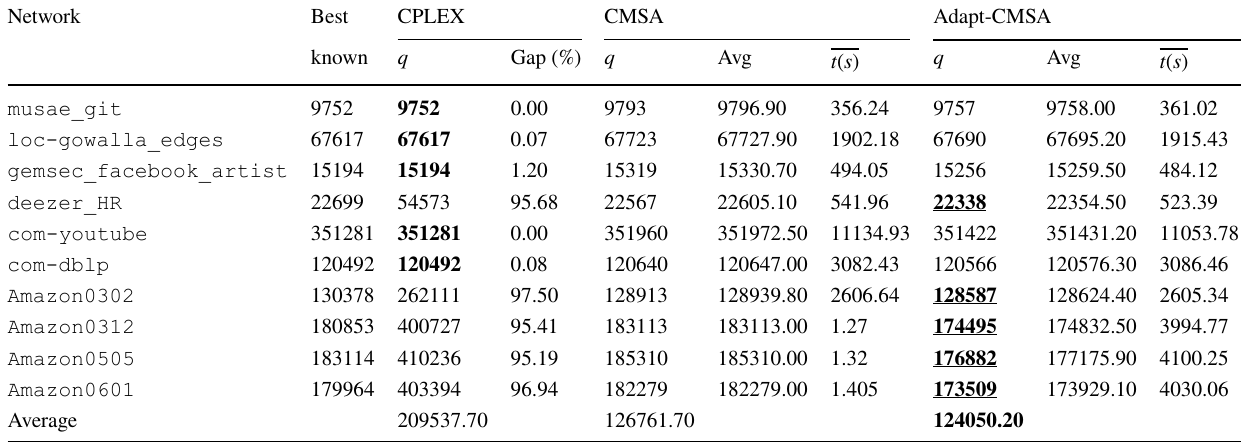
Table 2 Numerical results for large SNAP networks